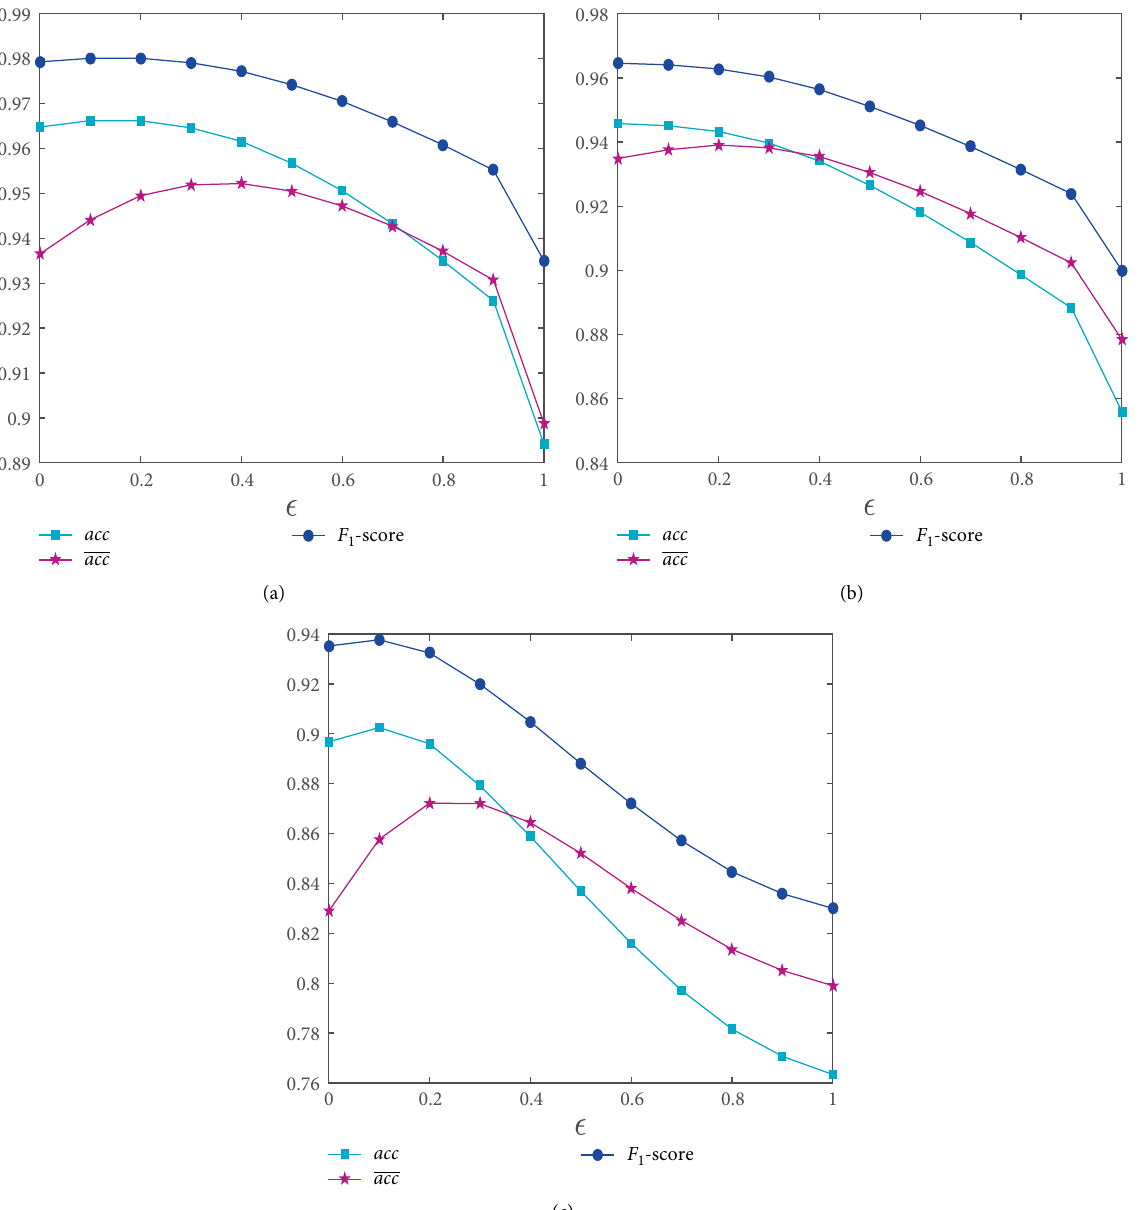
Figure 4: Experimental results of three real data sets under different 𝜖 . (a) Epinions. (b) Slashdot. (c)